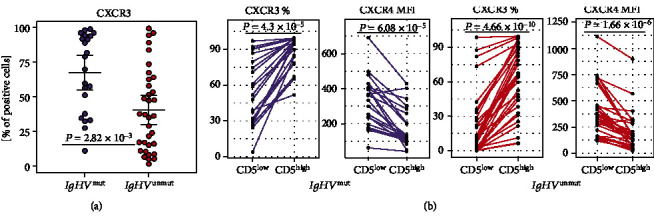
Distribution of CXCR3 and CXCR4 chemokines in IgHVmut (violet) and IgHVunmut (red) patients in (a) CLL cells as a whole, (b) CD5high, and CD5low subpopulations in a paired analysis. The lines connect the values on CD5high and CD5low subpopulations in the same patient.